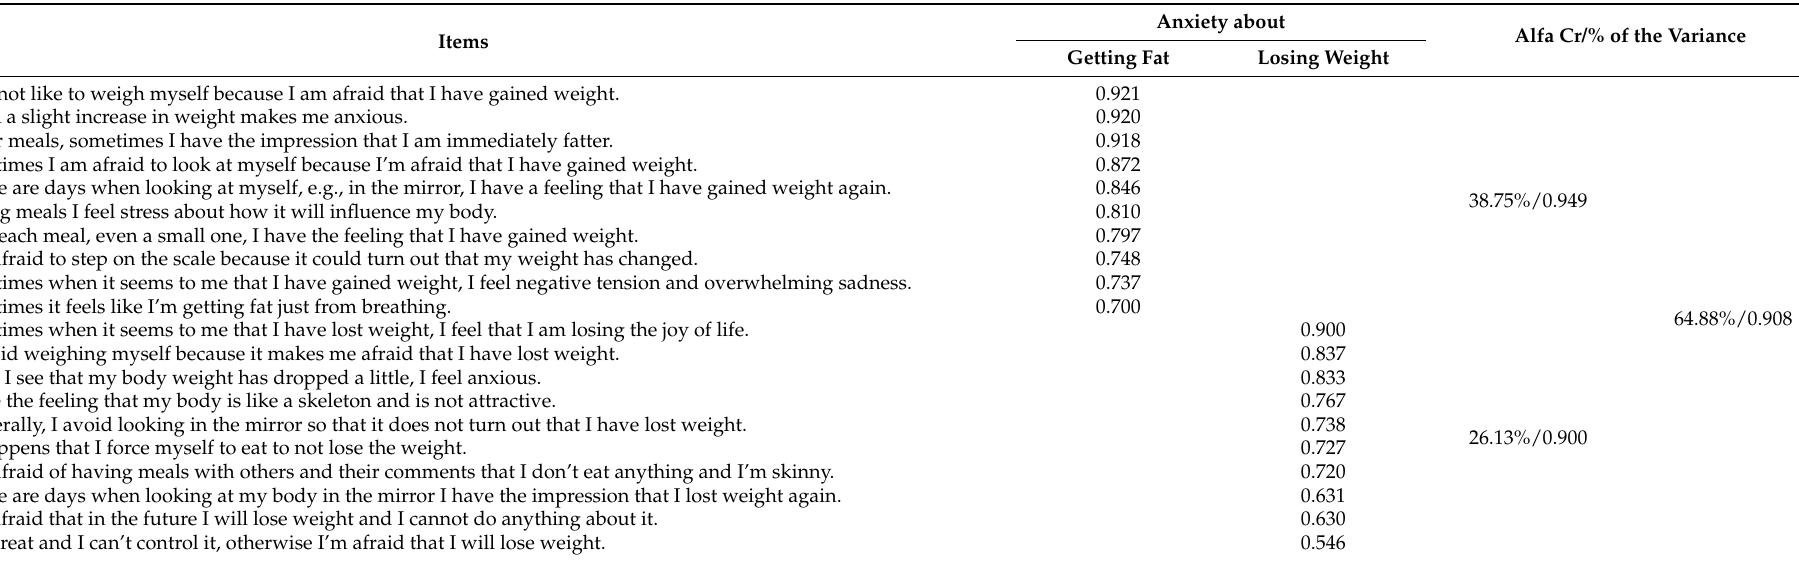
Table 2. Exploratory factor analysis of